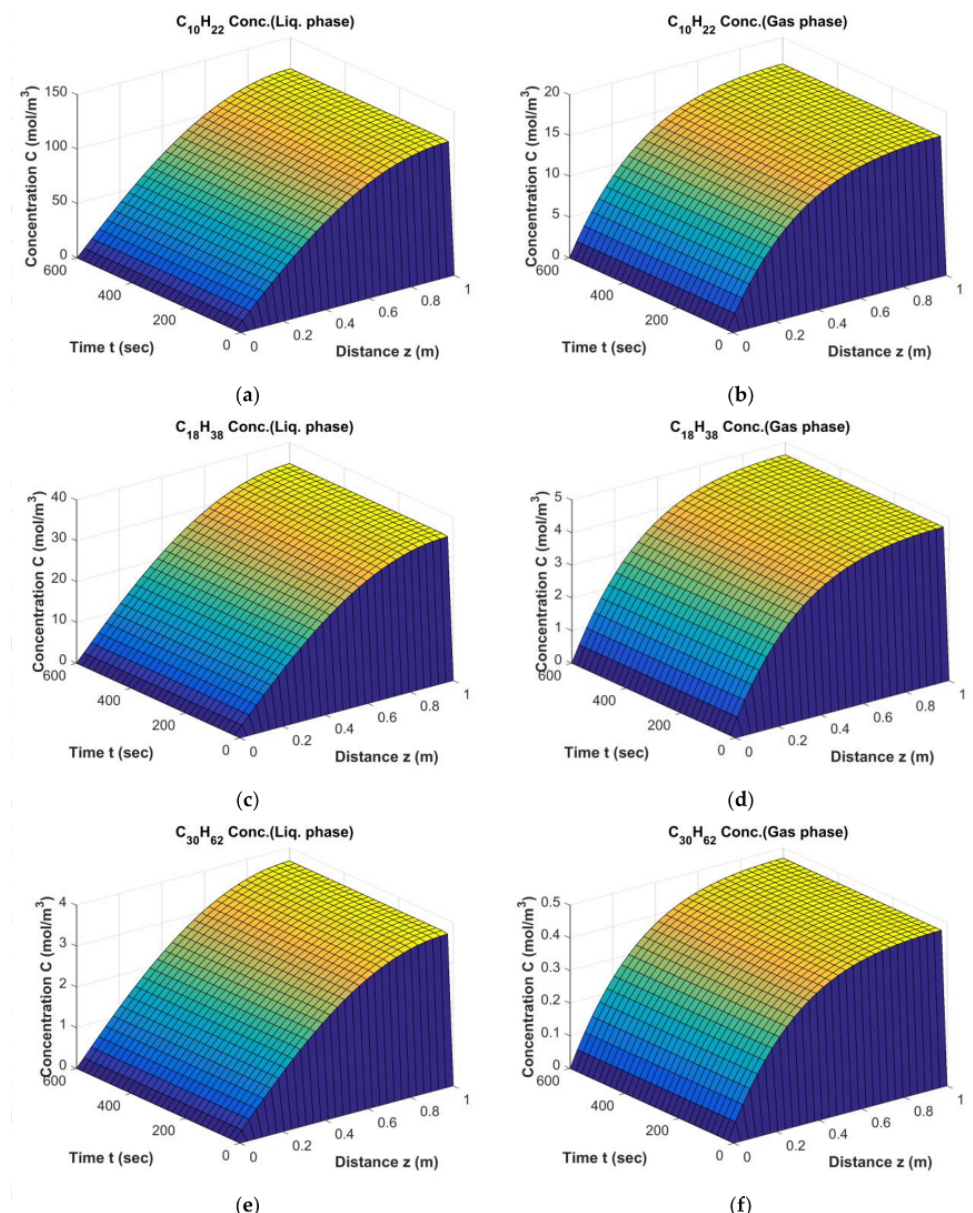
Figure 4. Results of FT simulation; The behavior of C 10 H 22 , C 18 H 38 and C 30 H 62 in liquid phase ( a , c , e ) and gas phase ( b , d , f ) from start-up to steady state conditions (D t = 0.1 m, H = 2.5 m, ε cat = 0.34, U g,in = 0.17